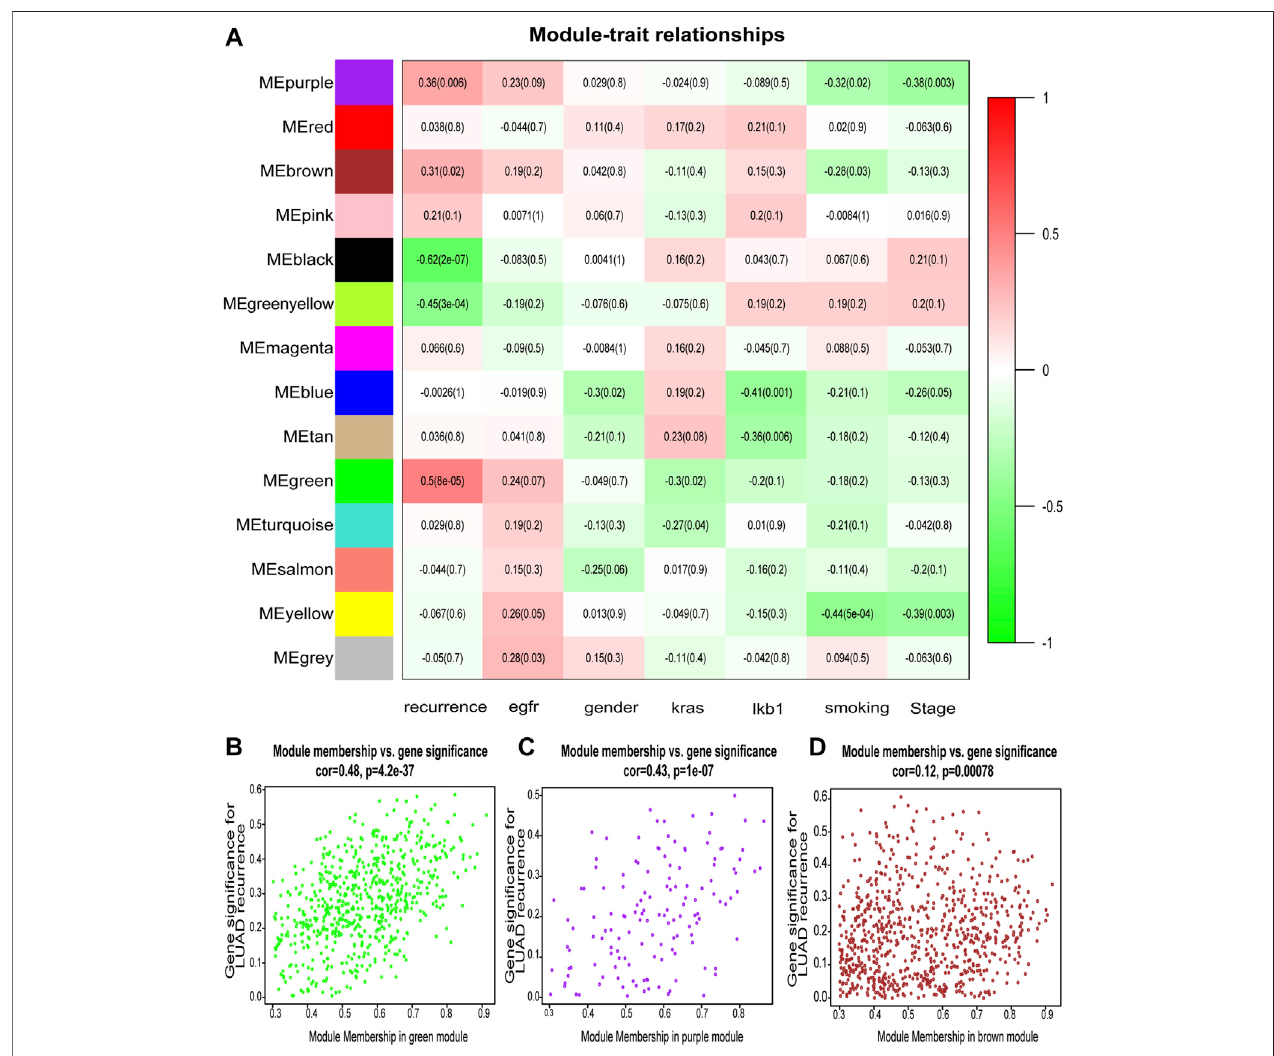
FIGURE 2 | Identi fi cation of modules associated with the clinical features of lung adenocarcinoma (LUAD). (A) Heatmap to show the correlation between modules andclinicaltraitswithLUAD. p -Valuesareshowninbrackets. (B – D) ScatterplotanalysistoshowtheassociationbetweenModulemembershipandgenesigni fi cancefor LUAD recurrence in green (B) , purple (C) , and brown modules (D) .